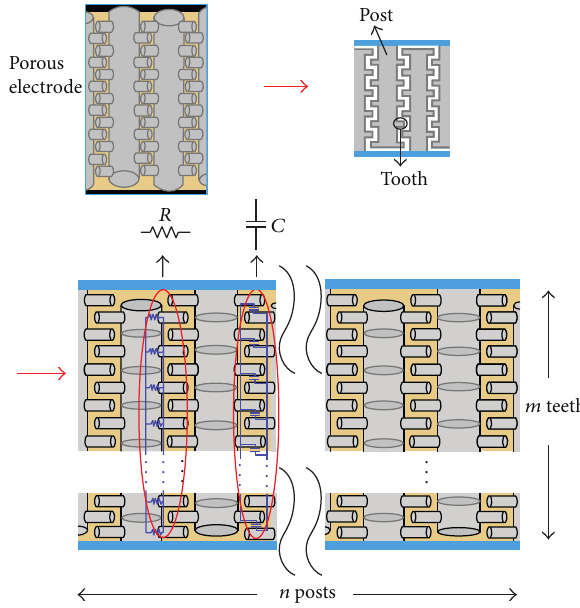
Figure 6: Pore model of the ultracapacitor electrodes.